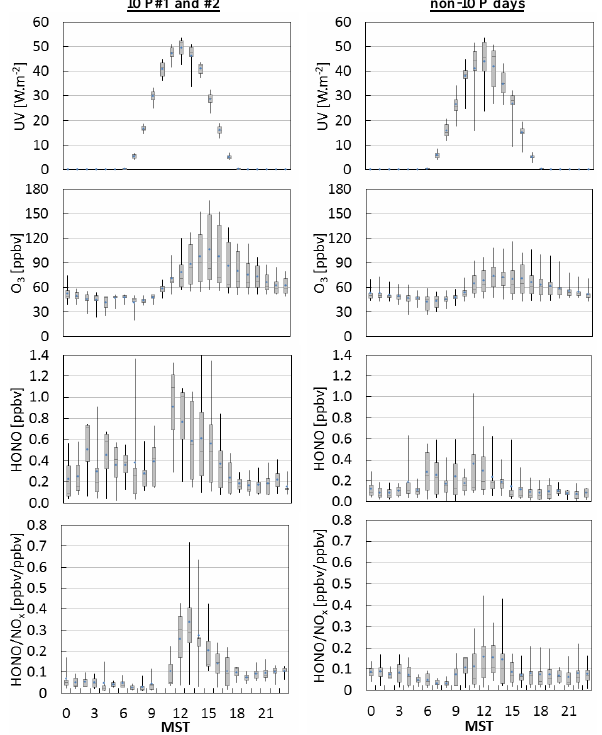
Figure 15. Mean diurnal variation of incoming UV radiation, ozone, HONO, and the HONO/NO x ratio for IOP and non-IOP